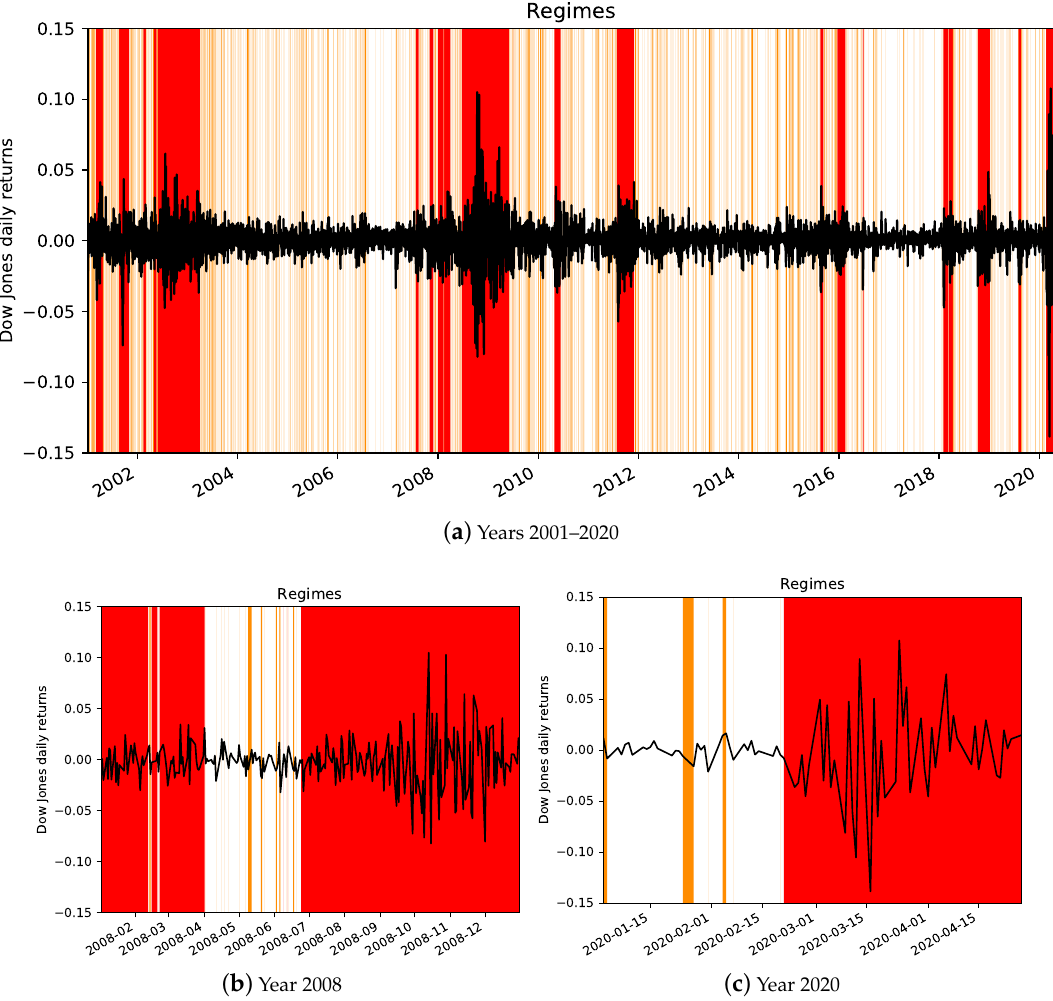
Figure 2. Time-series plots for the Dow Jones Industrial Average index returns and different regimes based on smoothed probabilities for the periods: 2001–2020 (Panel a ), 2008 (Panel b ), and 2020 (Panel c ). In all panels, the white, orange, and red colors identify the tranquil, volatile, and turbulent regimes,